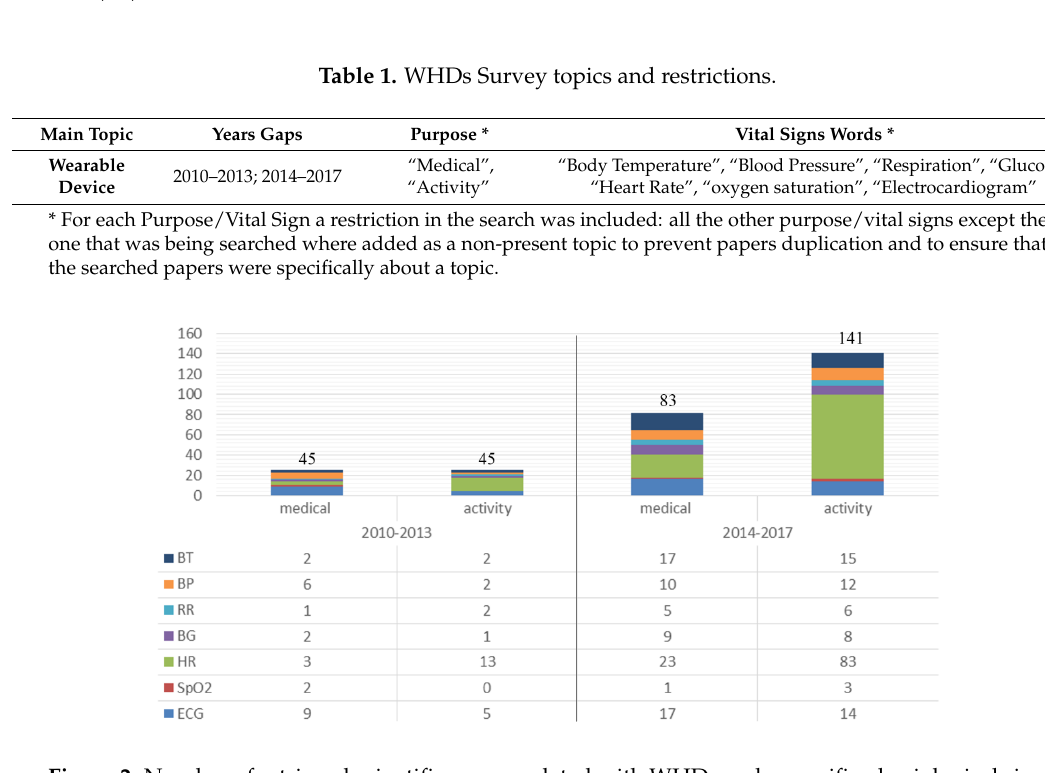
Figure 2. Number of retrieved scientific papers related with WHDs and a specific physiological sign. The distribution is divided in two time intervals and according to the purpose: medical or